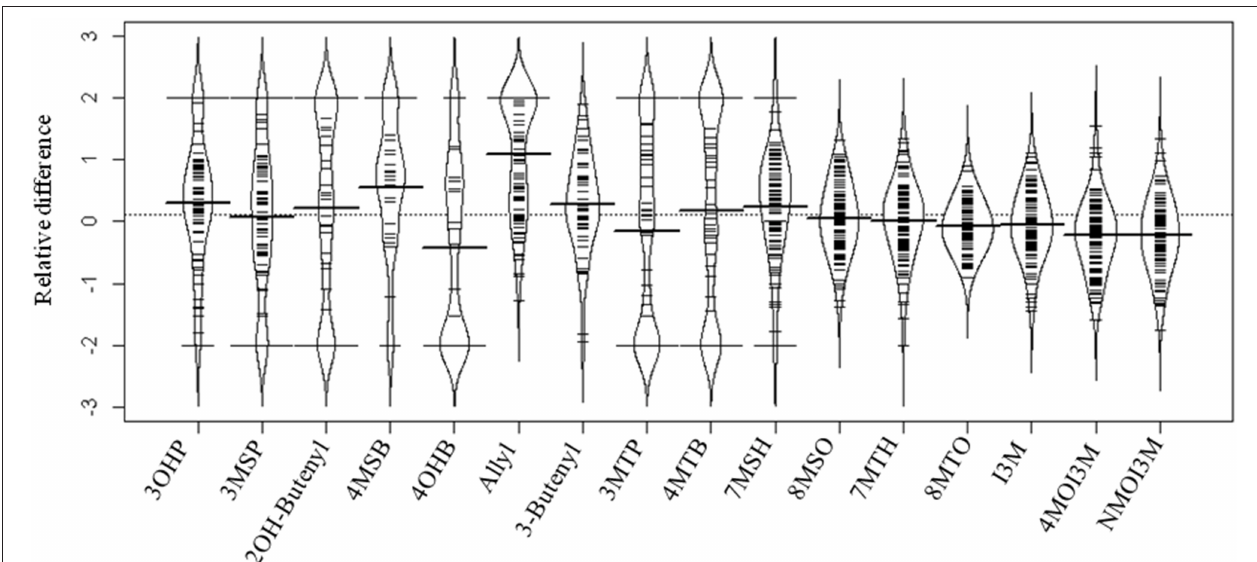
FIGURE 2 | Distribution of the relative difference of individual GSL accumulation in response to allyl GSL treatment across the Arabidopsis accessions. A beanplot is used to show the distribution of the change in GSL accumulation between the treated and untreated samples across the accessions using the abbreviations in Table S1. Relative difference was determined as (GSL treatment − GSL control)/(0.5 × [GSL treatment + GSL control]). The dashed line in the middle of the plot is the overall average of the relative GSL difference between control and allyl treatment across all GSL. The thick black line in the middle of each bean for each compound is the mean response for that specific GSL trait across all the accessions. The black colored curved bean pod surrounding the observations is the theoretical probability density distribution of these observations. The small lines represent individual data points, with the length of the line proportional to the number of observations with that specific value. The relative difference between treatment and control varied across the 96 accessions from − 2 to 2 for each GSL compound, depending on whether that GSL was present in the treatment compared with control.